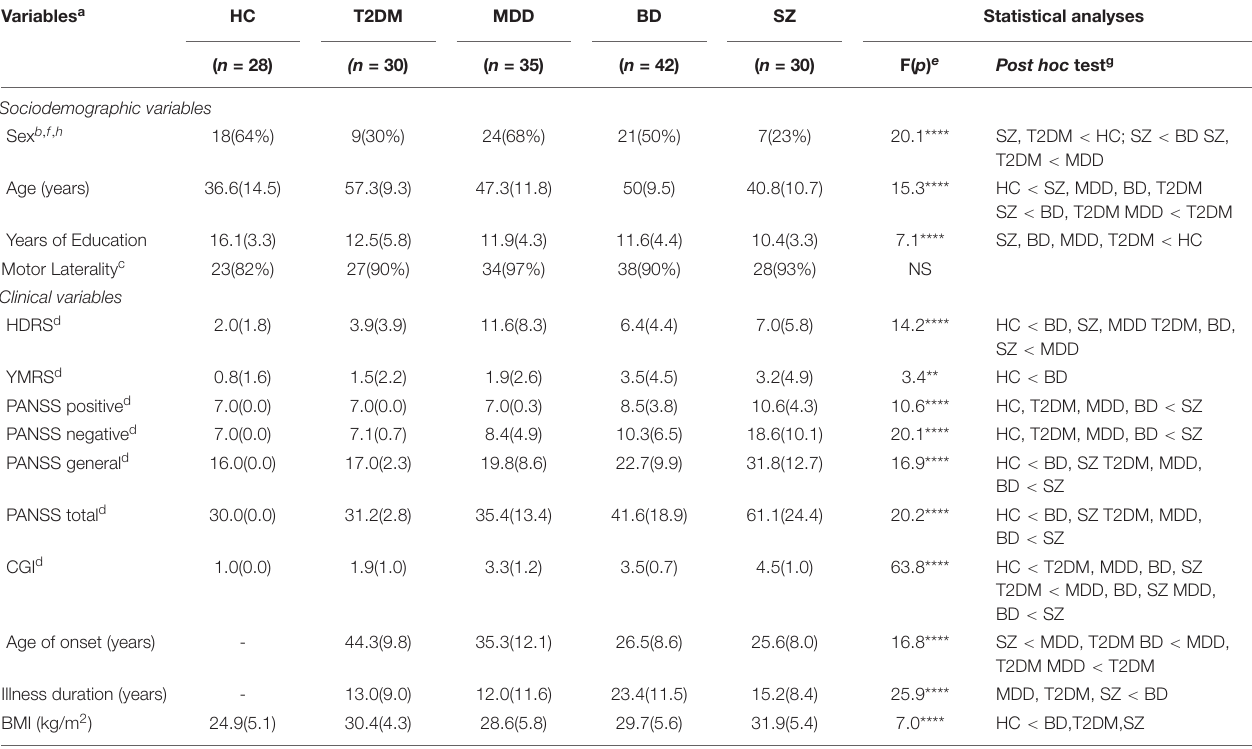
TABLE 1 | Sociodemographic and clinical characteristics of the sample at T1. Variables a HC T2DM MDD BD SZ Statistical